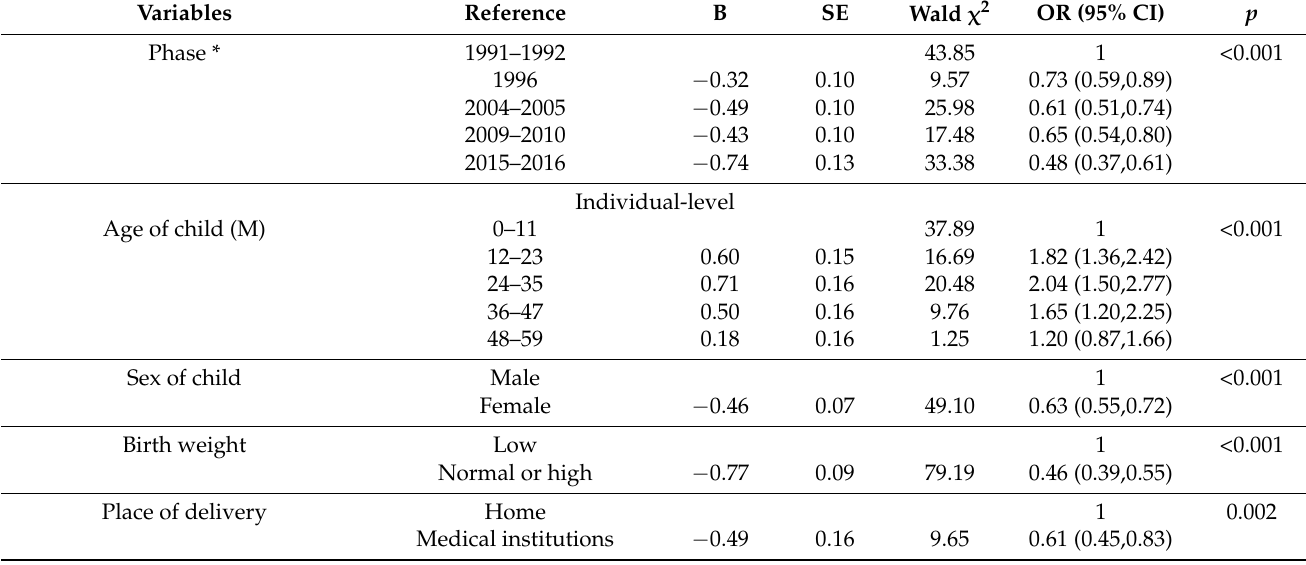
Table 2. The determinants of under-5 child stunting in the urban area based on 1991–2016 Tanzania Demographic and Health